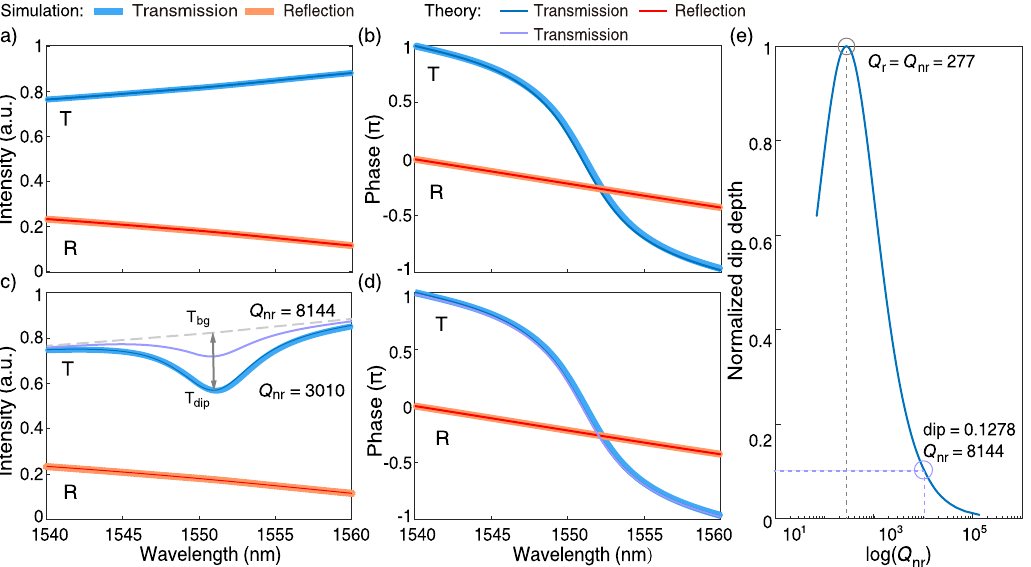
Figure 2: Characterization of reflectance and transmittance near a UGR from numerical simulations (bold lines) and TCMT theory (narrow